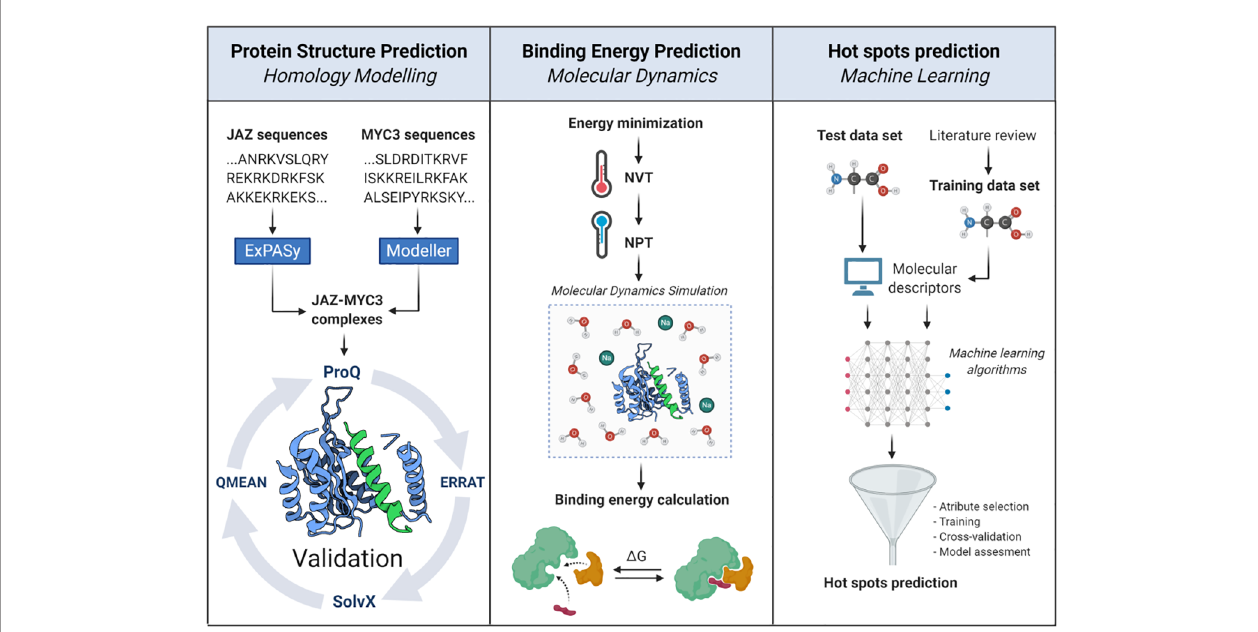
FIGURE 2 | In silico work fl ow proposed to unravel structural, energetic, and molecular features of JAZ-MYC3 complexes. The pipeline is divided into three stages: protein homology modeling, binding energy calculation, and molecular hotspots